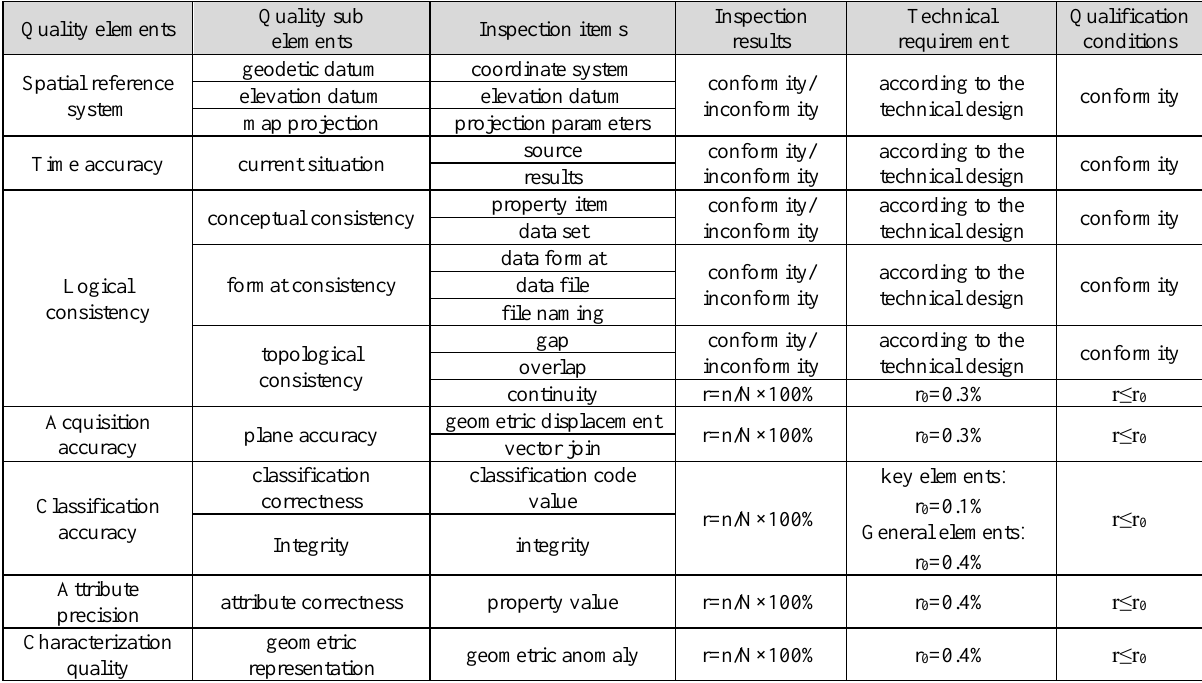
Table 2. Quality evaluation index of land cover classification